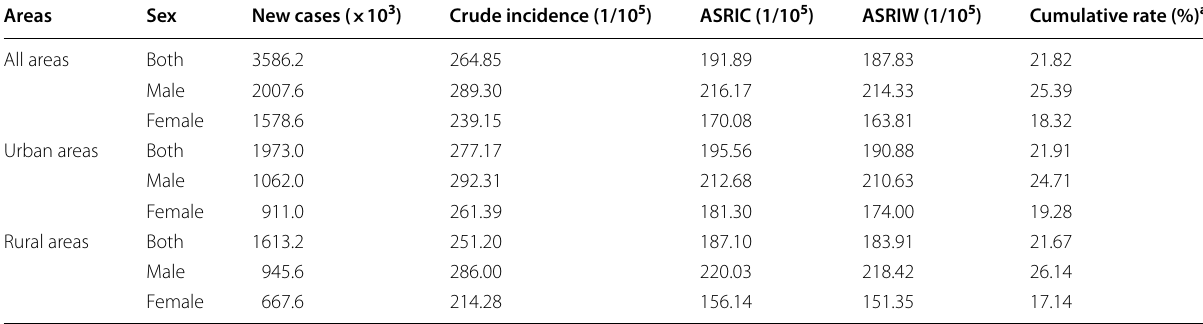
Table 1 Cancer incidence in China in 2012 (This table has been published previously and is reproduced with permission from the Chinese Journal of Cancer Research , see Ref.